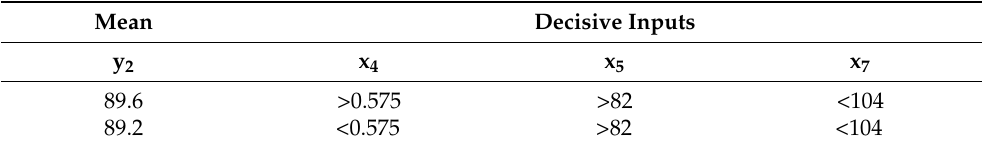
Table 3. The most decisive inputs and their optimal values for the Cz-Ge growth with high growth rate y 2 , derived from RT analysis. The data ranges correspond to the white nodes in Figure 6. Mean